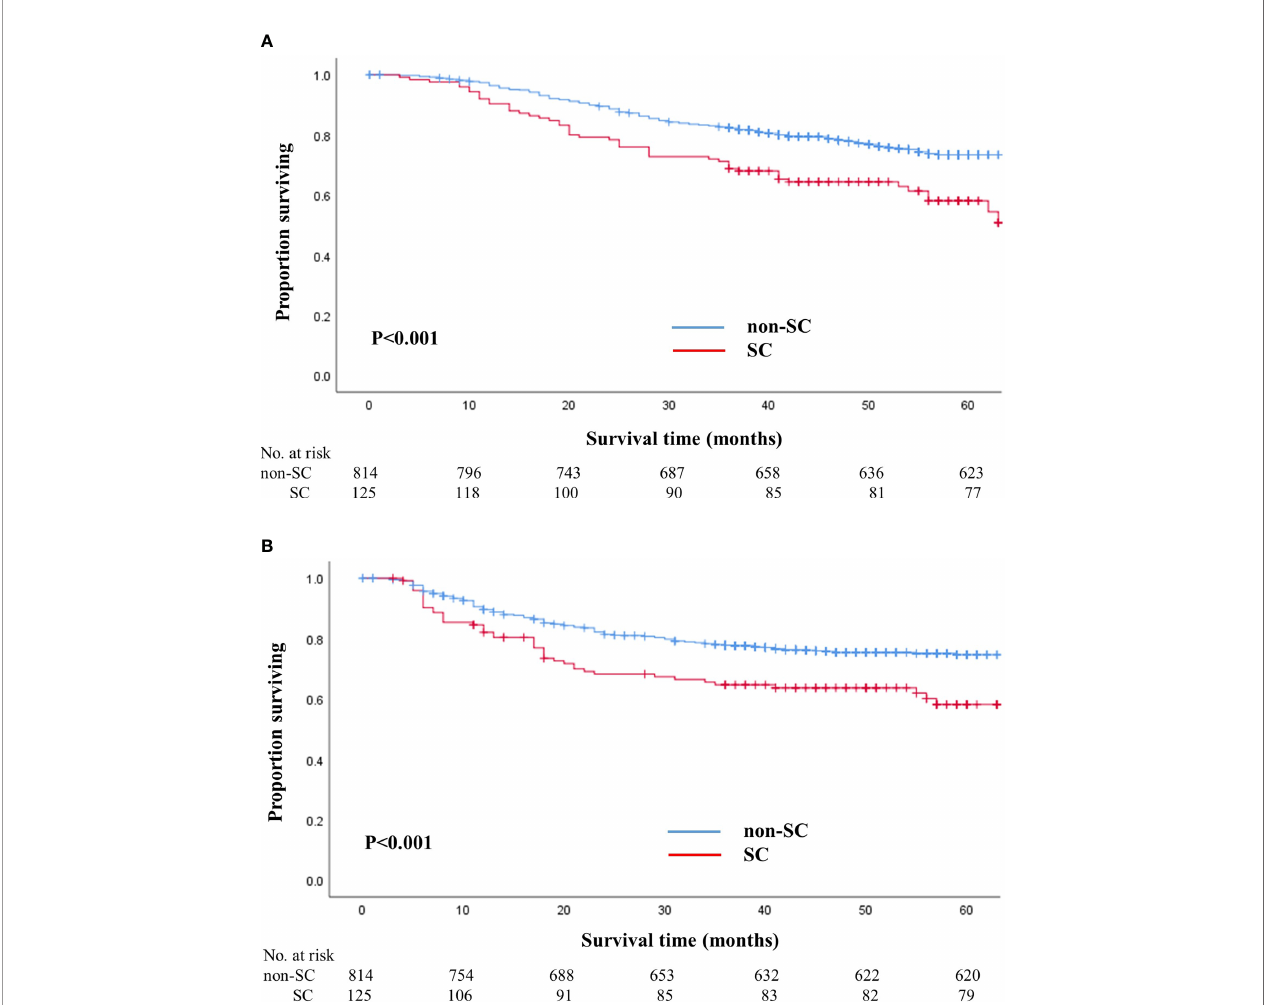
FIGURE 1 | Overall (A) and recurrence-free (B) survival in patients with and without serious complications. (A) Overall survival in patients with and without serious complications. (B) Recurrence-free survival in patients with and without serious